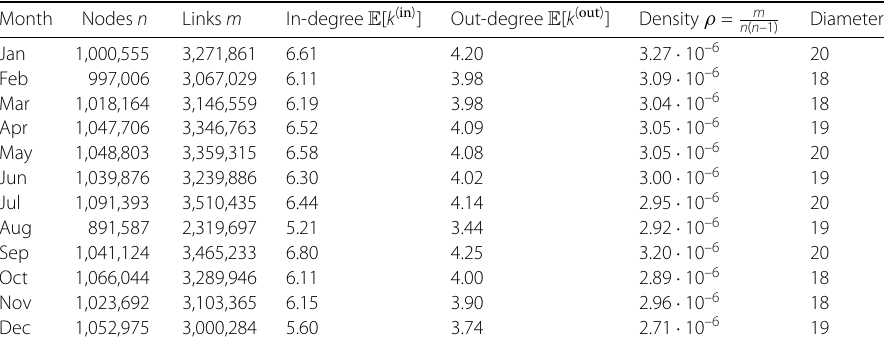
Diameter d n ( n –1)